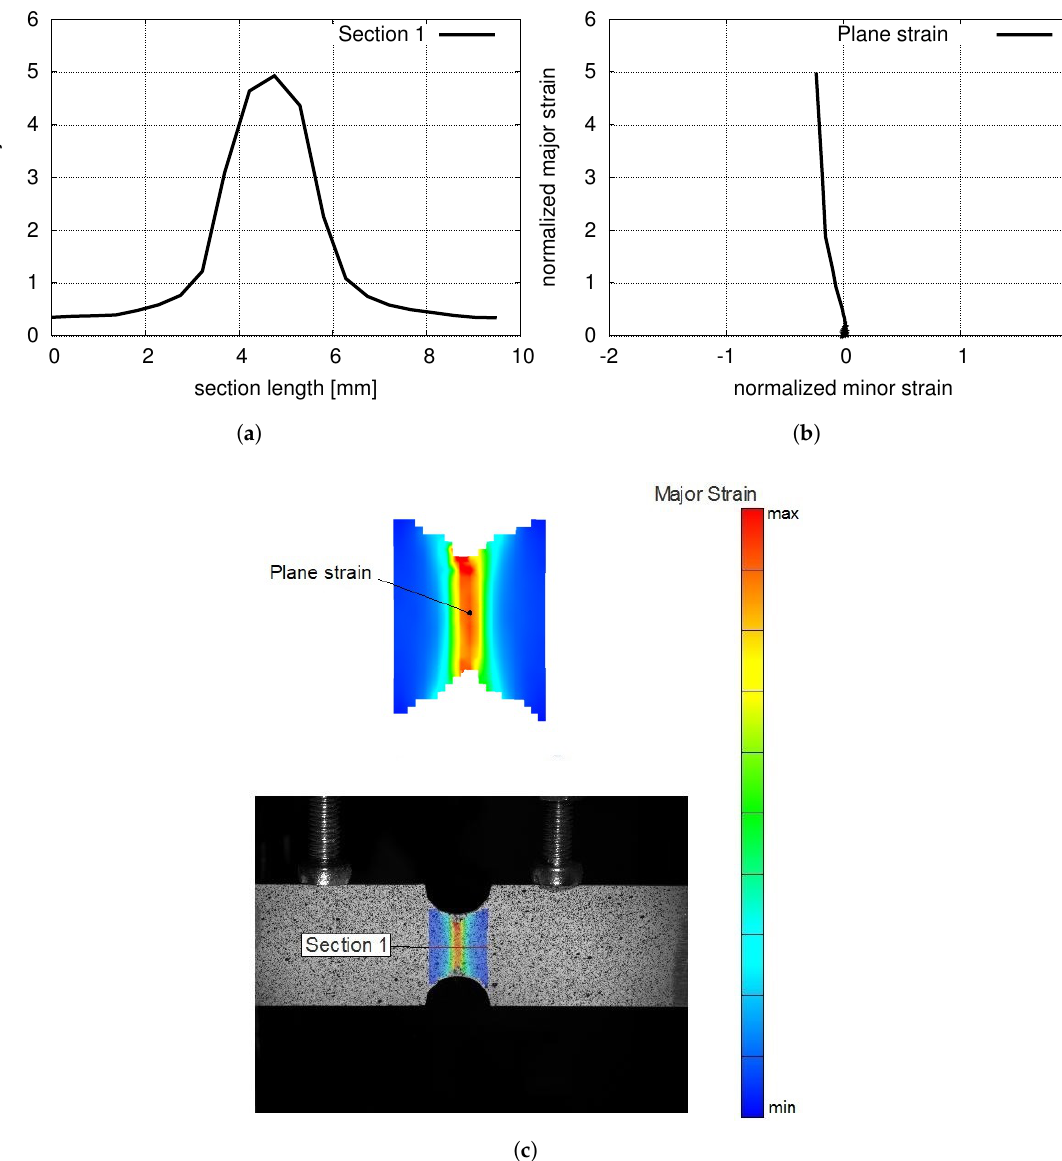
Figure 17. Strain distribution along the notch width normalized with respect to the mean uniform strain ( a ), experimentally determined limit strain with normalized strains with respect to the mean uniform strain ( b ) and the evolution of necking ( c ) in the pre-failure regime of a notched